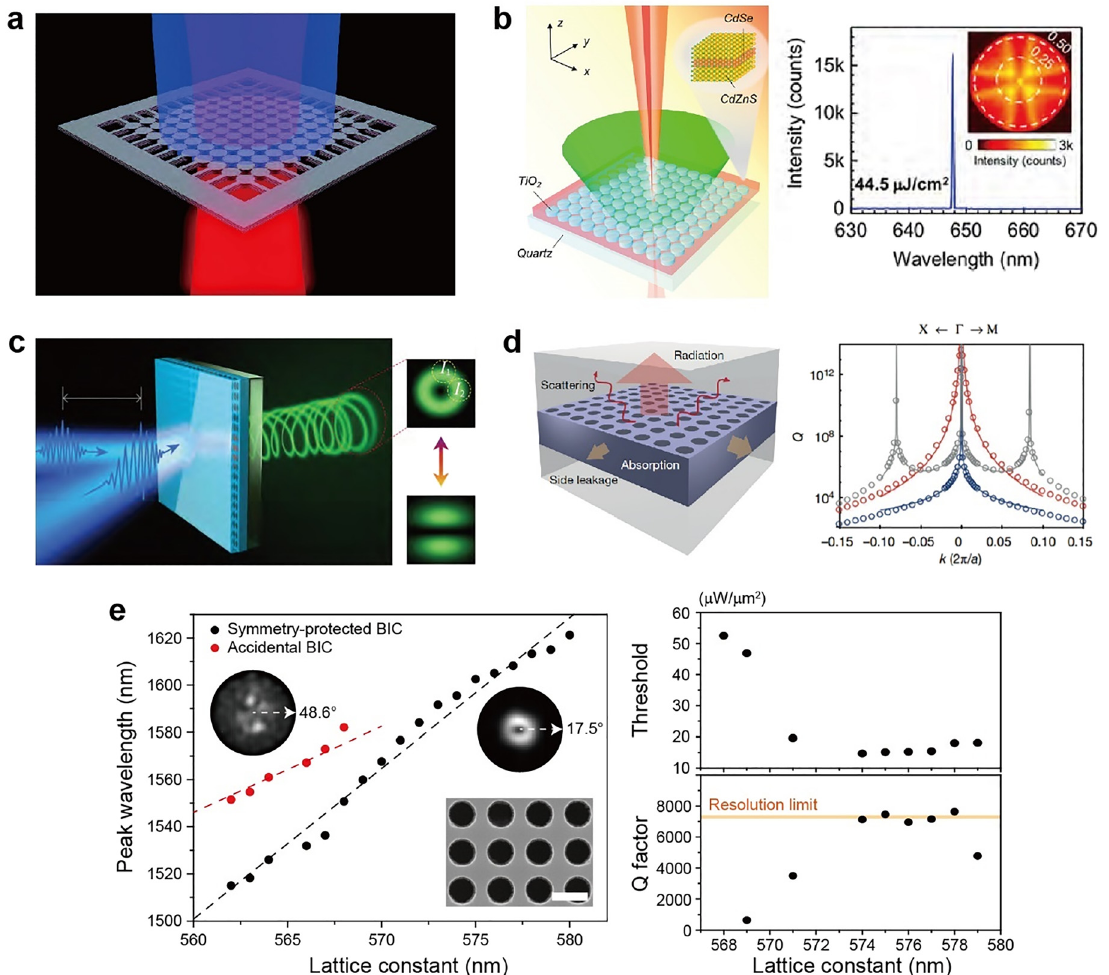
Figure 5: Representative BIC lasers. (a) Schematic of BIC laser composed of a periodic array of InGaAsP nanodisks with supporting bridges (adopted from Ref. [57]). (b) Schematic (left) and measured lasing spectrum (right) of the BIC laser consisting of an array of TiO 2 cylinders covered with CdSe/CdZnS core – shell nanoplatelets.Theinsetoftherightpanelshowsthebackfocalplaneimageattheonsetoflasing(adoptedfromRef.[58]).(c)Ultrafastcontrol of vortex microlaser. Two beams are spatially induced with a delay time. The right images show the far- fi eld image patterns under both symmetric and asymmetric excitations (adopted from Ref. [62]). (d) Left, schematic of the merging-BIC structure. Right, calculated Q factors before merging (grey), at merging (red), and after merging (blue) (adopted from Ref. [55]). (e) Super-BIC laser. Left, measured lasing wavelengths of the symmetry-protected BIC lasers (black dots; right inset) and accidental BIC lasers (red dots; left inset) as a function of the latticeconstant.ThebottominsetshowstheSEMimageofthefabricatedlaserstructurewitha=563nm.Right,measuredthreshold(top)and Q factor (bottom) as a function of the lattice constant. The threshold values are divided by the pump area ( ∼ 5.4 μ m in size). The Q factor is obtained using λ / Δ λ , where λ is the lasing wavelength and Δ λ is the linewidth at the transparent pumping condition (adopted from Ref.